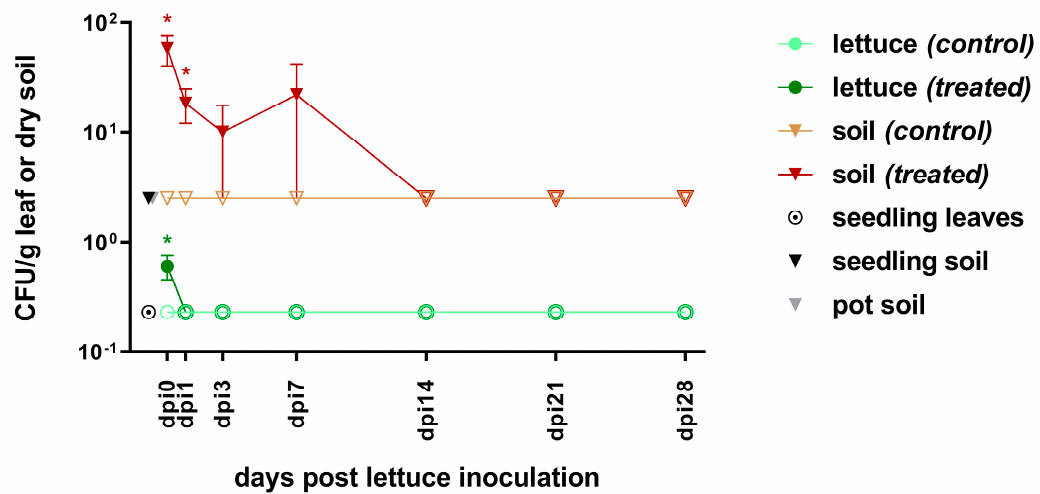
Figure A1: Detail view on survival of E. coli pEK499 in soil and lettuce after low-level contamination via irrigation water, Table A1: Primers for triplex PCR, Table A2: Cycling conditions for triplex PCR.